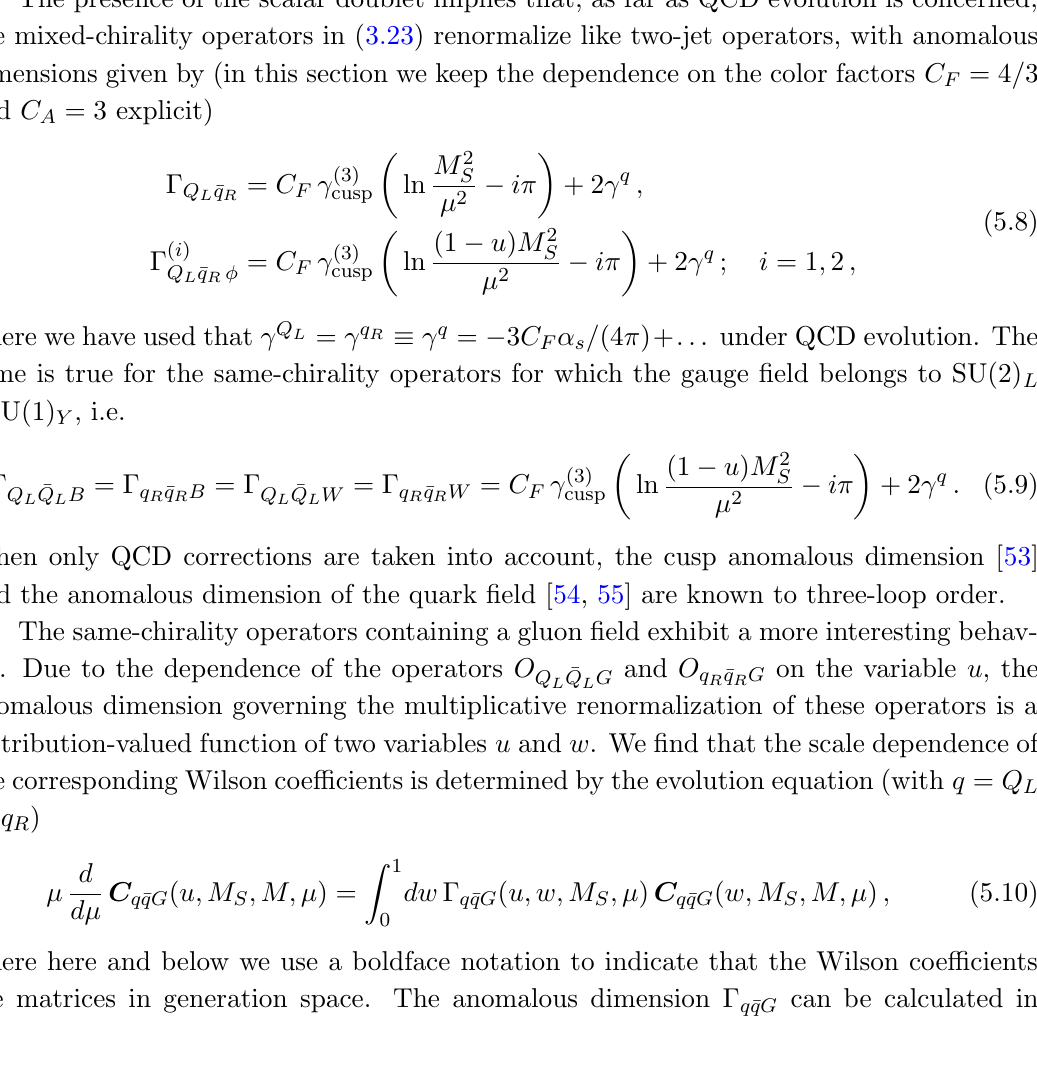
Figure 2 . One-loop diagrams contributing to the anomalous dimension (cid:0) dashed line represents the heavy scalar resonance S . Solid lines denote collinear quarks, curly lines with dashes denote collinear gluons, and simple curly lines represent ultra-soft gluons. Collinear (cid:12)elds moving along the same direction are drawn next to each